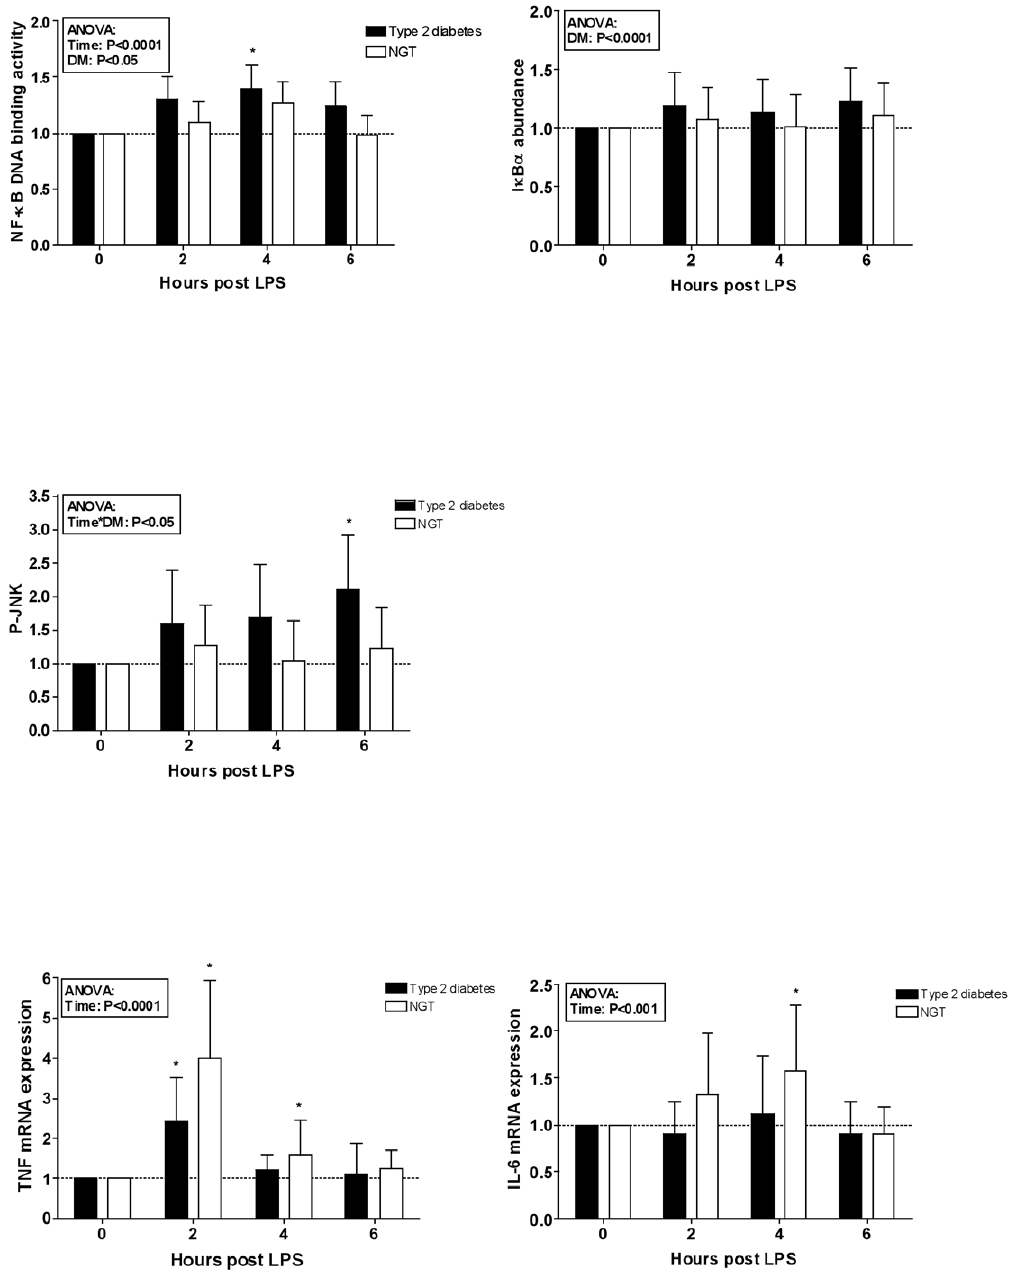
Figure 2. Fold increases in NF- k B, I k B a , p-JNK, TNF a mRNA and IL-6 mRNA after LPS. Fig. 2 Fold increases (mean and 95% confidence interval) from baseline following an intravenous injection of LPS in 10 patients with diabetes ( & ) and 10 volunteers with normal glucose tolerance ( % ). * P , 0.05 compared to baseline. LPS: lipopolysaccharide, NF- k B: nuclear factor k B, I k B a : inhibitor of NF- k B a , p-JNK: phosphorylated c-Jun-N- terminal kinase, TNF a : tumour necrosis factor-alpha, IL-6: